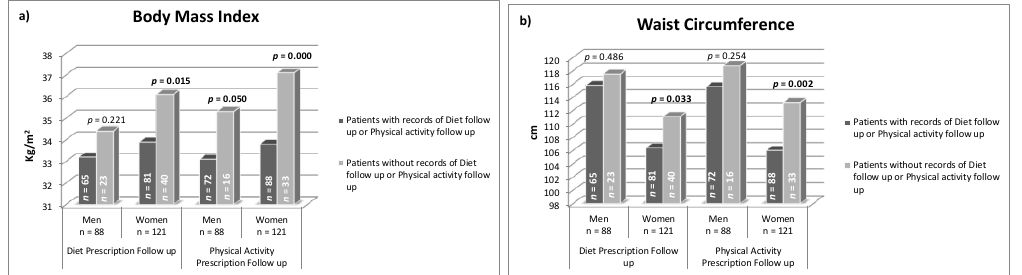
Figure 2. ( a ) Current mean body mass index and ( b ) mean waist circumference in patients with and without records of diet or physical activity follow-up, in clinical history. Table 4. Lineal regression model (women): ( A ) BMI (dependent variable); ( B ) WC (dependent variable).